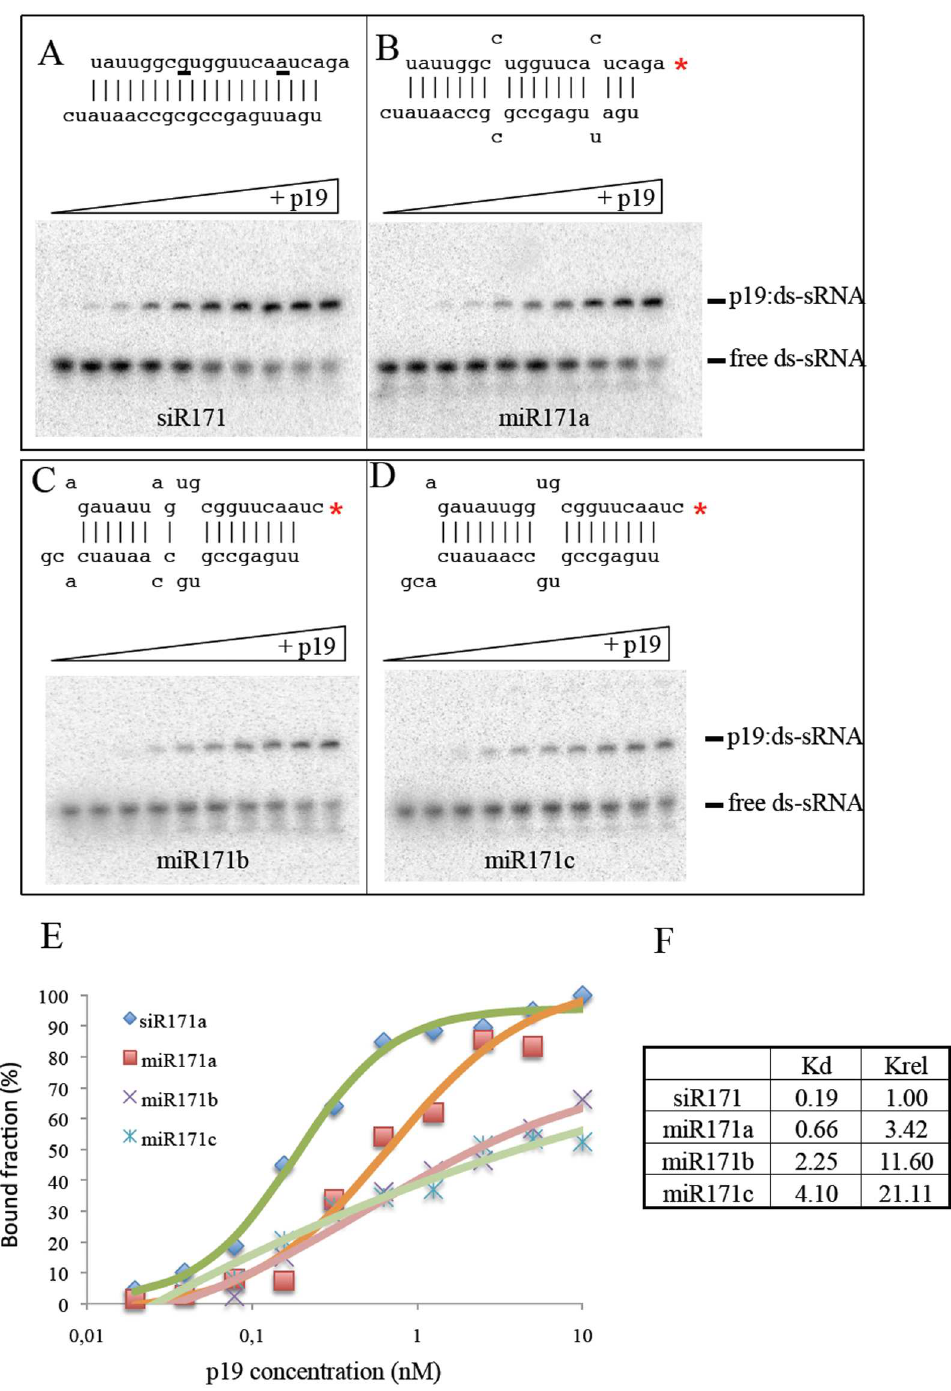
Fig 4. Affinity of p19 to perfect or mismatch-containing duplex si/miRNAs in vitro . Band shift assay of perfect duplex siR171 (A), and mismatched miR171a(B), miR171b(C) and miR171c (D) duplexRNAs’ with p19 protein. The structure of dsRNAs is shown above the gel pictures. Direct measurement of the absolute apparentdissociationconstant Kd values (F) were calculated as previously described[57] based on the quantification of band intensities of p19:dsRNAbound fraction as a function of p19 protein concentration (E). Relativedissociationconstant (Krel) was calculatedby normalization of Kd values to Kd of siR171 (F).